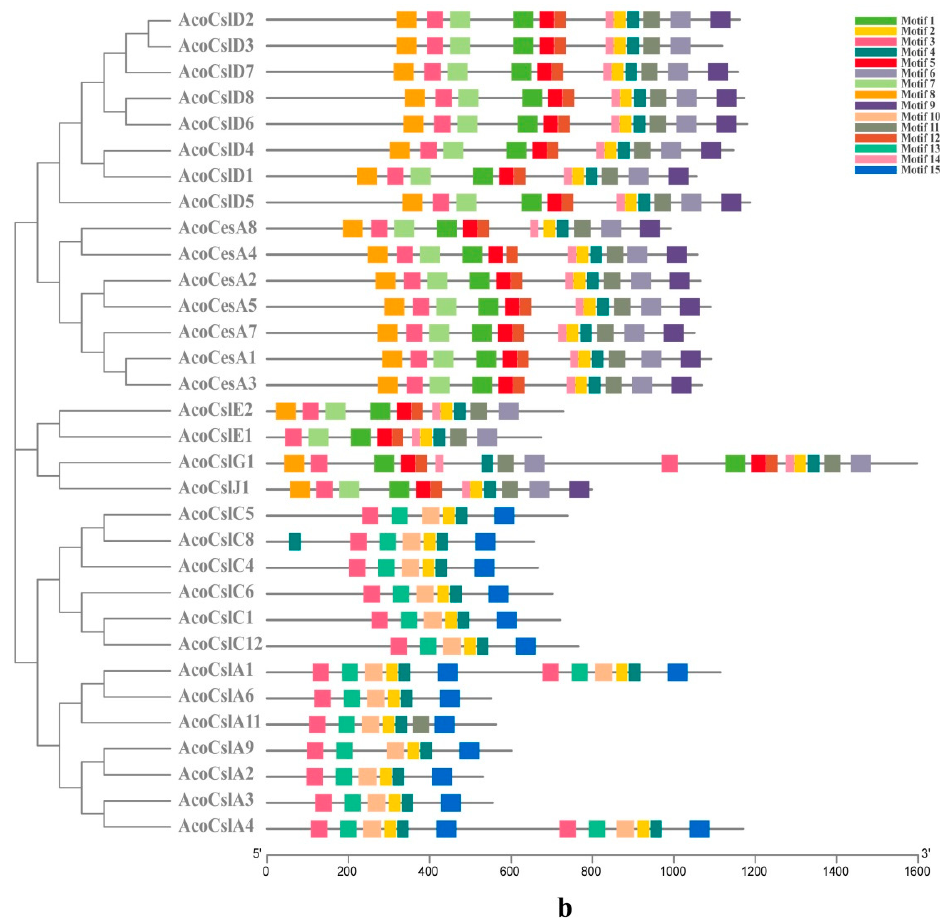
Figure 2. ( a ) Exon-intron structure of pineapple Ces / Csl genes. Bule boxes indicated untranslated 5’- and 3-regions; yellow boxes indicated exons; black lines indicate introns. The prefix ‘Aco’ indicates Ananas comosus . ( b ) Motif analysis of the pineapple Ces / Csl protein. Motifs with specific colors can be found on the respective AcoCes / Csl protein. The combined phylogenetic trees of AcoCes / Csl subfamily on the left panel. The motifs of corresponding proteins are shown on the right panel with specific colors on behalf of di ff erent motifs using the Multiple Em for Motif Elicitation (MEME). The order of the motifs corresponds to their position within individual protein sequences. Prefix ‘Aco’ indicates Ananas comosus